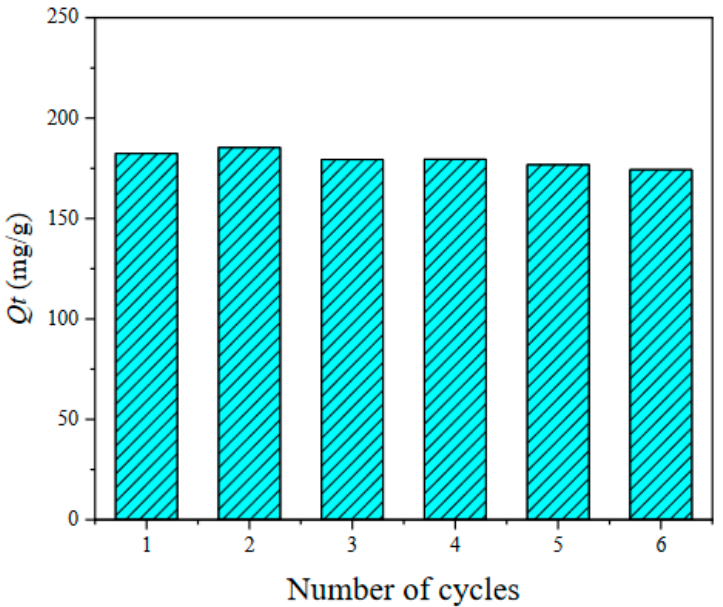
Figure 8. The regeneration cycles for phenol adsorption over the L-CN-700 sample. Adsorption conditions: C 0 = 133 mg/L, m / v = 0.4 g/L, 20 °C, t = 90 min.